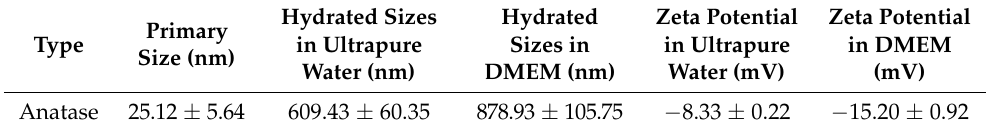
Table 1. Physicochemical properties of TiO 2